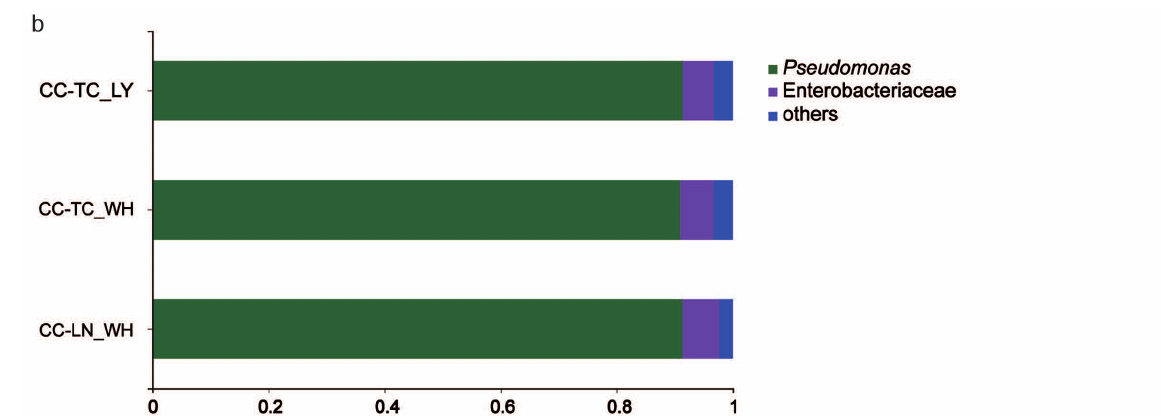
Figure 4. Taxonomic composition of bacterial community at the genus level in ants ( a ) and spiders ( b ). TC_LY, T. caespitum Luoyang; TC_WH, T. caespitum Wuhan; LN_WH, L. niger Wuhan; CC-, spiders fed different diets.